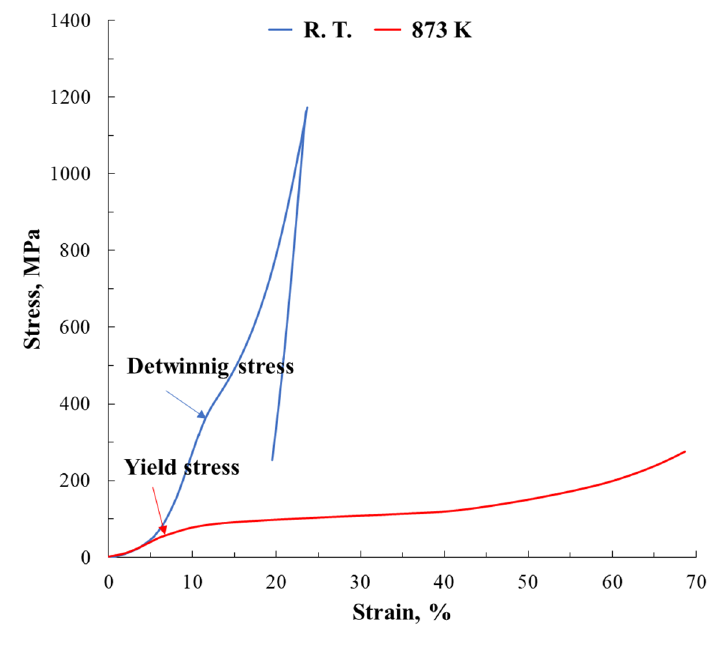
Figure 3. Compress test of equiatomic TiPd alloy.